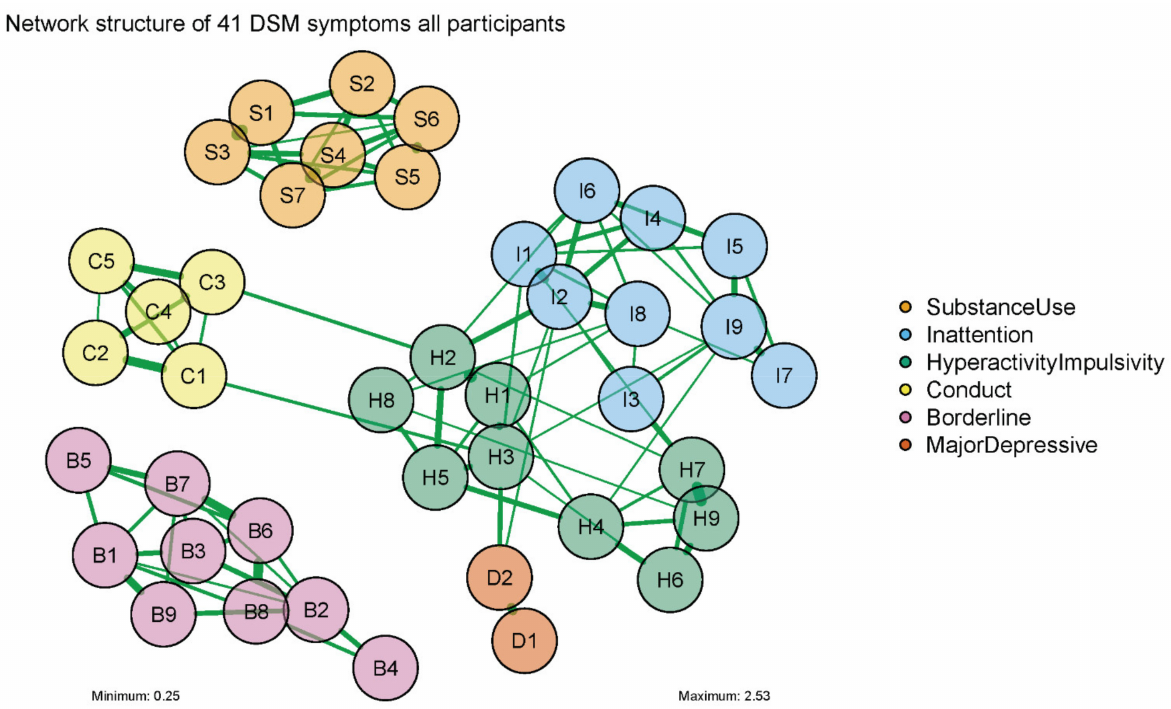
Figure 1. Network structure of 41 DSM symptoms of SUD, ADHD, CD, MDD, and BPD for total sample ( n = 772) (IsingFit). Description of each symptom (node) is presented in Table